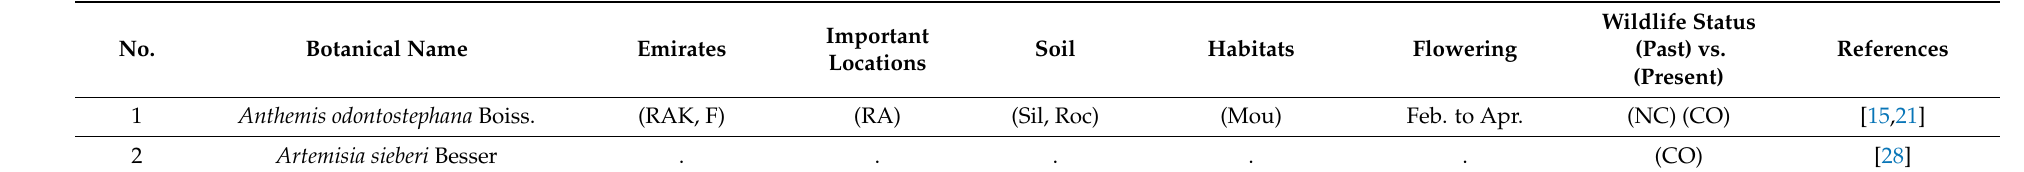
Table 5. Location of the UAE EO-bearing plants of